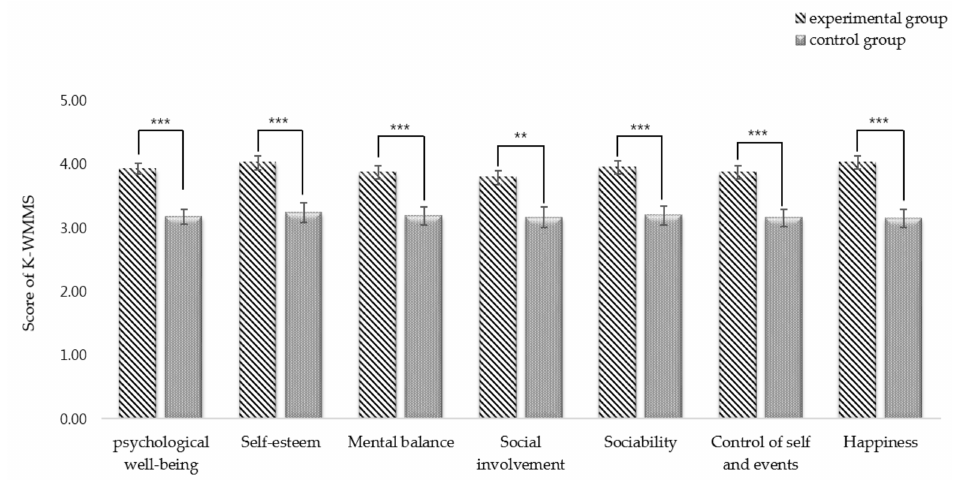
Figure 3. The effect of forest therapy on psychological well-being, comparing experimental and control groups, ** p < 0.01, *** p < 0.001.